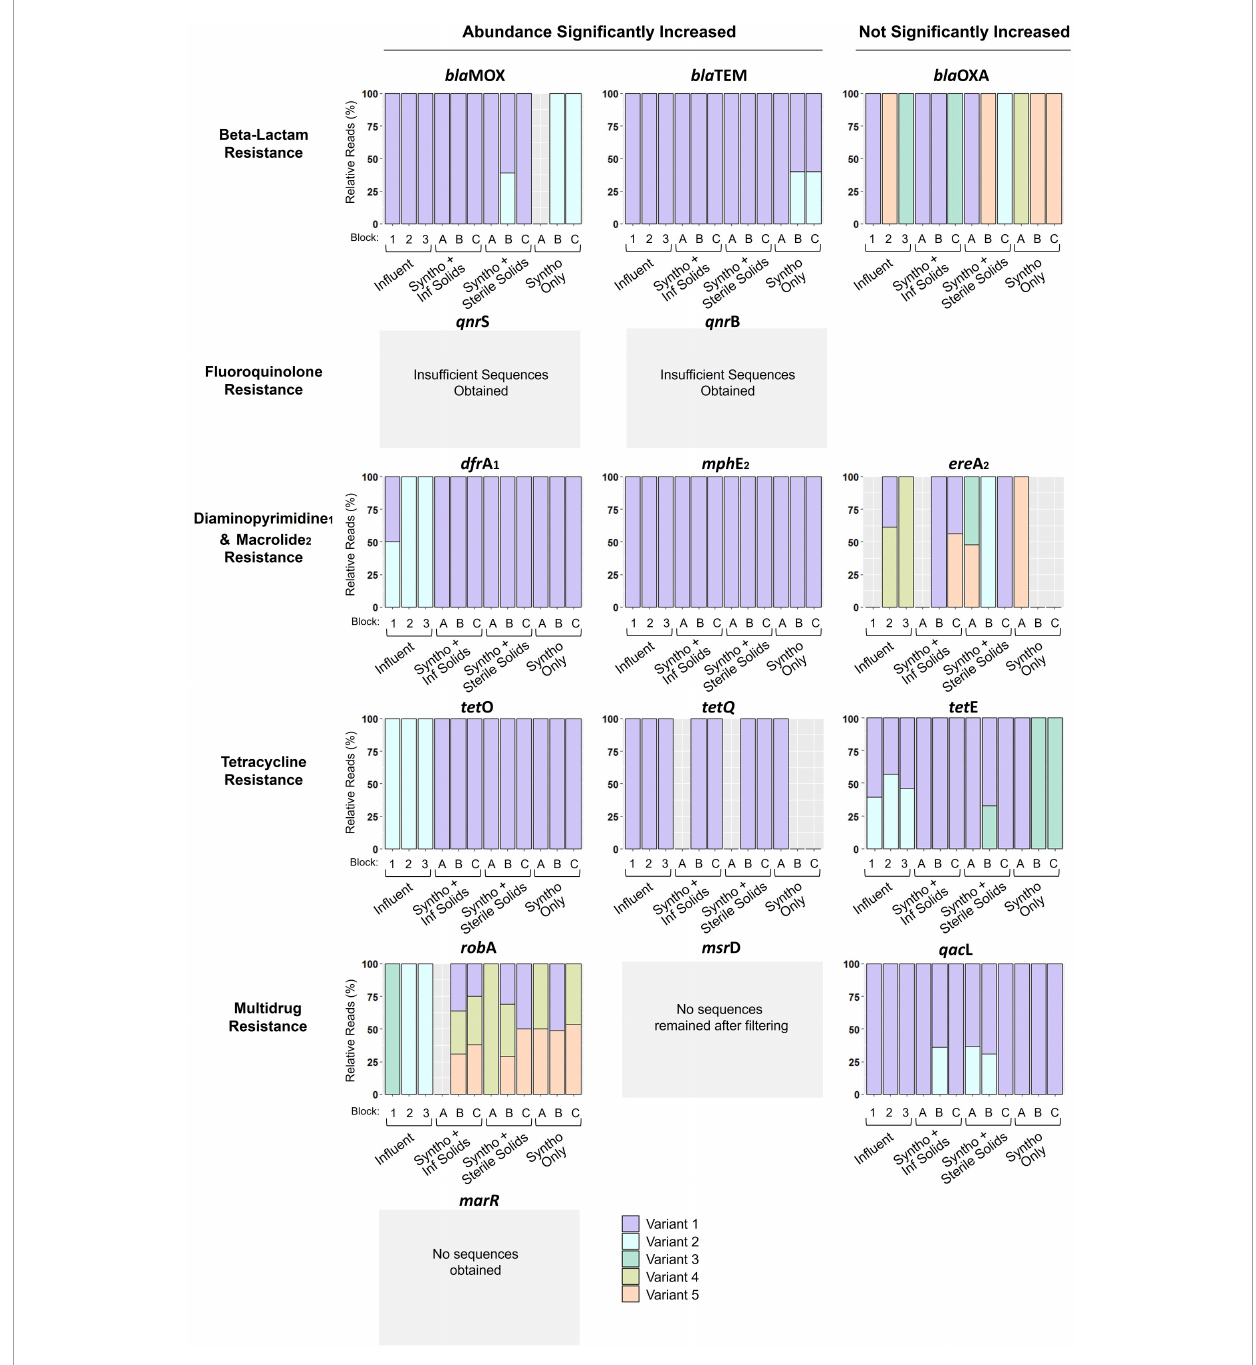
FIGURE4 ARG ASVs detected using multiplexed amplicon sequencing. Reactors with immigration received Syntho and influent (Inf) solids. Reactors receiving Syntho and sterile influent solids acted as a substrate control. Reactors with Syntho only acted as a no immigration control. Each sample represents a pool of biological triplicates. Block represents the inoculum of the reactor A- La Prairie Mixed Liquor, B- Cowansville Mixed Liquor, C- Pincourt Mixed Liquor. Influent 1, 2, and 3 represent the order in which they were fed to the reactors during Phase 2, with influent 3 received for the final solid retention time (SRT). All reactor samples analyzed were obtained from the final day of Phase 2. The msr D, mar R, qnr B, and qnr S gene ASVs were undetected after the sequence filtering process either because they did not survive the stringent filtering process ( msr D and qnr B), or insufficient reads were obtained resulting in no detection ( qnr S and mar